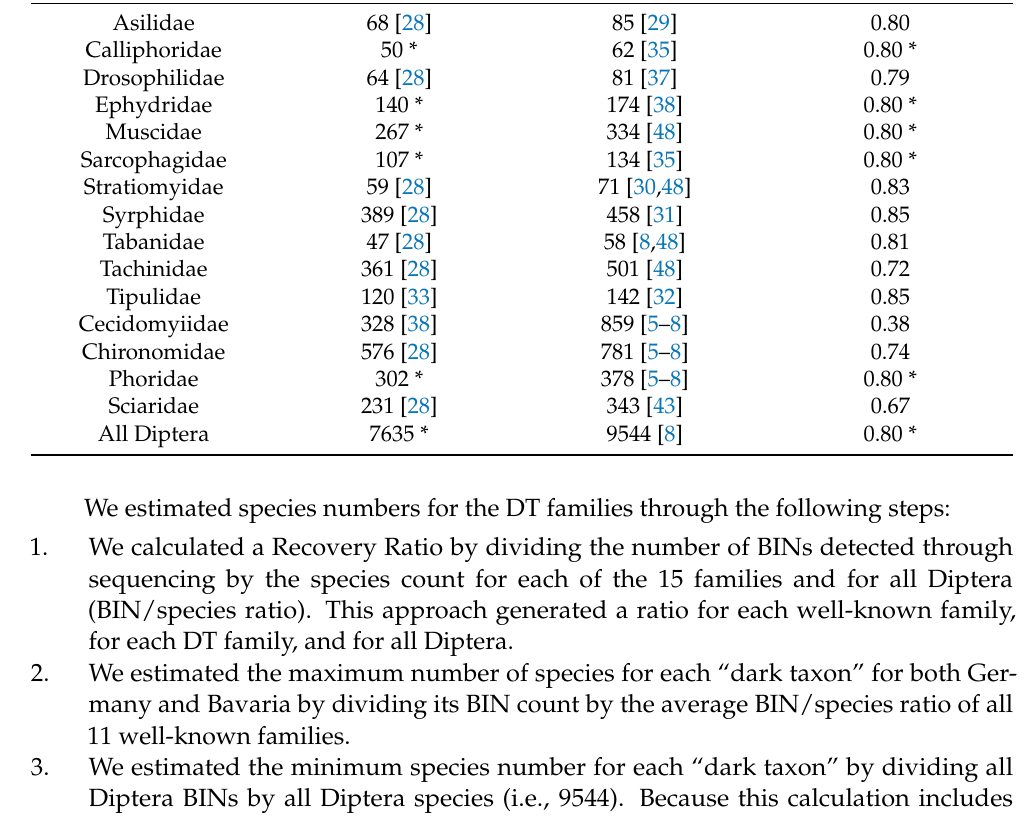
Table 2. Species numbers for 15 families of Diptera. Species numbers for the Bavarian and German faunas are shown for 11 families of Diptera with well-established taxonomy and for four families with limited knowledge (Cecidomyiidae, Chironomidae, Phoridae, Sciaridae). *—estimated at 80% of German fauna. Bavarian Taxon